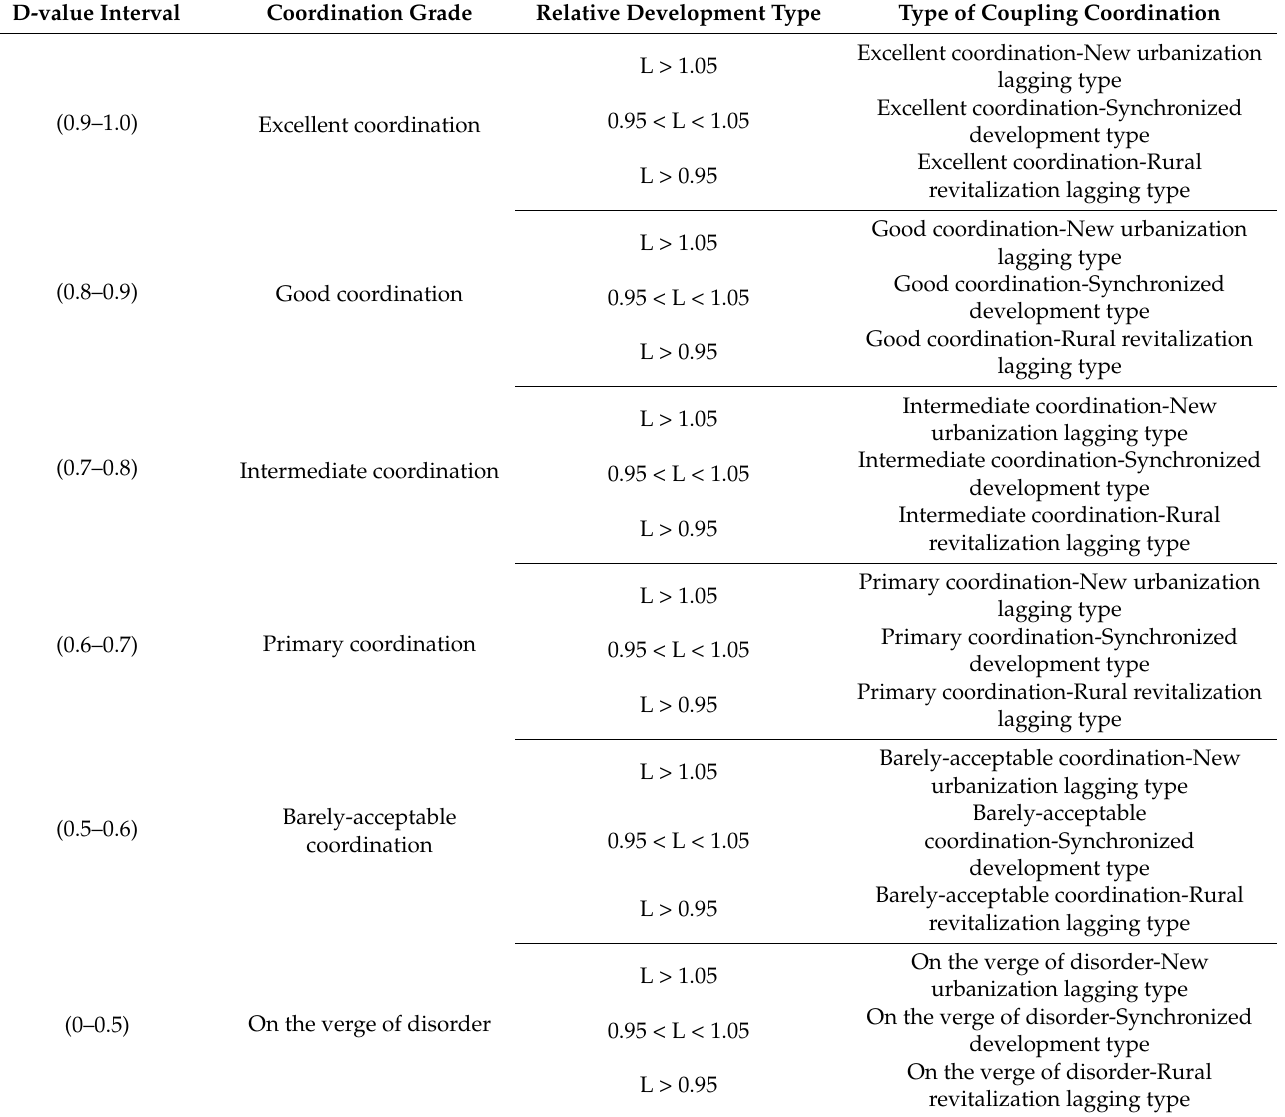
Table 2. Criteria for classifying the type of coupling coordination